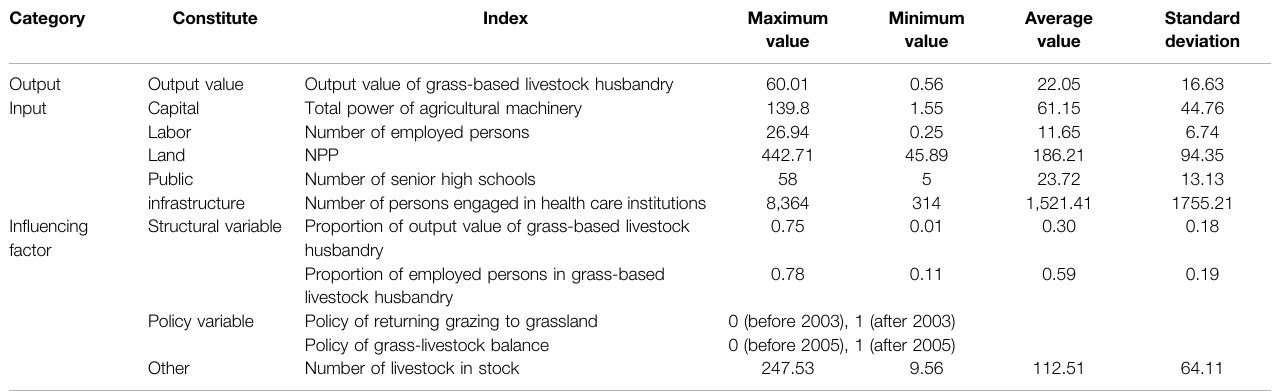
TABLE 1 | Evaluation index of ecological ef fi ciency of grass-based livestock husbandry in each county of Tongliao. Category